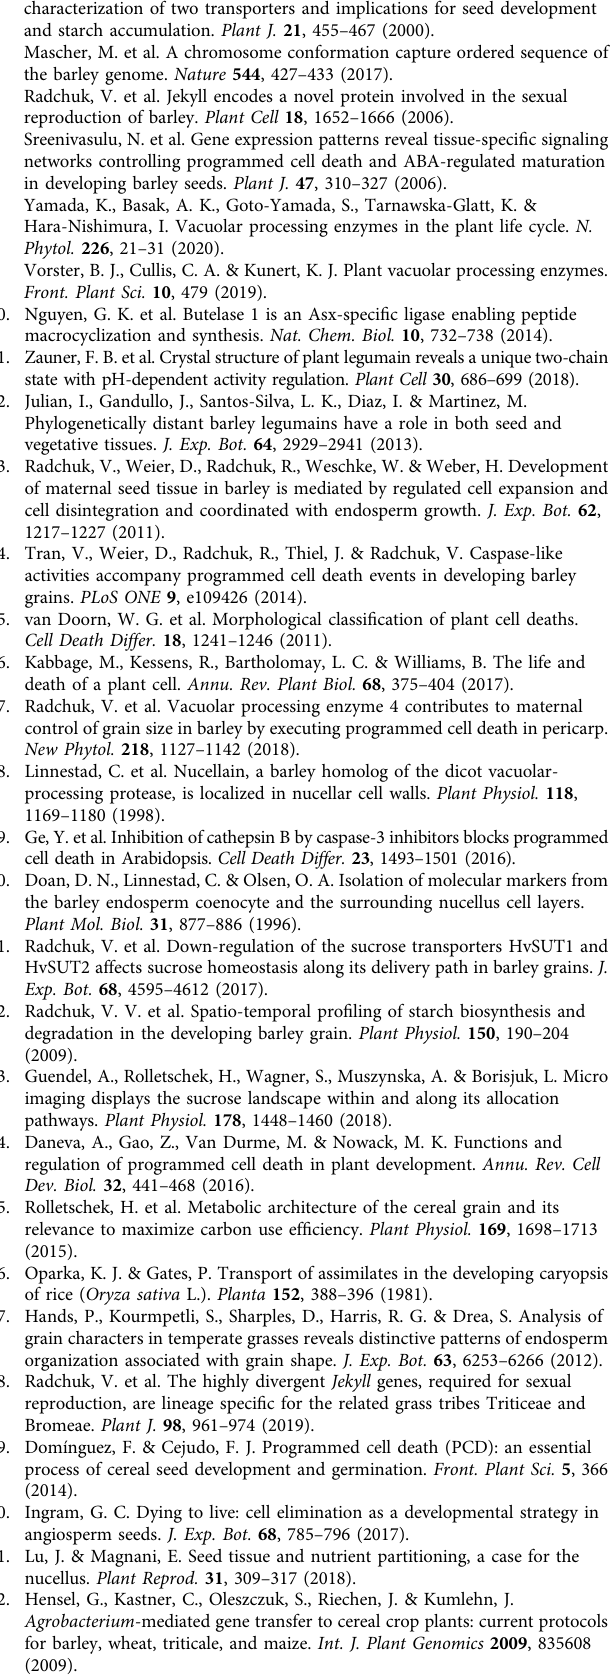
Table 4. The phylogenetic trees were constructed using the maximum-likelihood methods in MEGA6 with the following option settings: Poisson substitution model, uniform rates, partial deletion for gaps/missing data, 95% site coverage cutoff, strong branch swamp fi lter, and 1000 bootstrap replications. Statistics and reproducibility . Statistical analysis and the number of technical and biological replicates for each experiment are indicated in fi gure legends and cor- responding descriptions of methods. Phenotypic parameters of RNAi-VPE2- repressed grains were veri fi ed by analyzing independent batches of plants growing at different time periods. Besides four lines, analyzed in the manuscript, additional homozygous lines were grown and phenotypic parameters of their grains were evaluated. RNAi-mediated repression of VPE2a , VPE2b , and VPE2d genes was veri fi ed by qRT-PCR analysis of the grains from the independent batch of plants. All replicates were